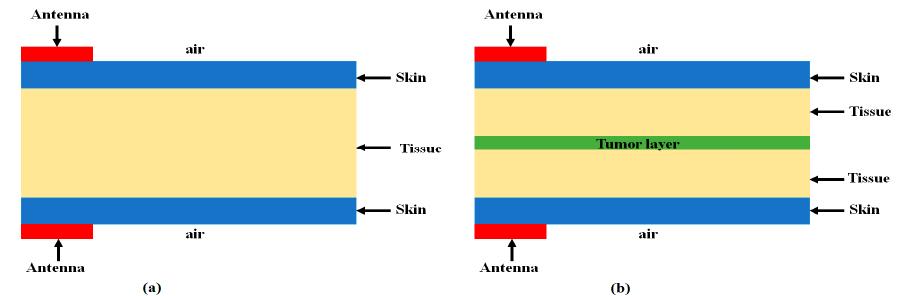
Table 5. Dielectric properties of the skin, tissue, and tumor.